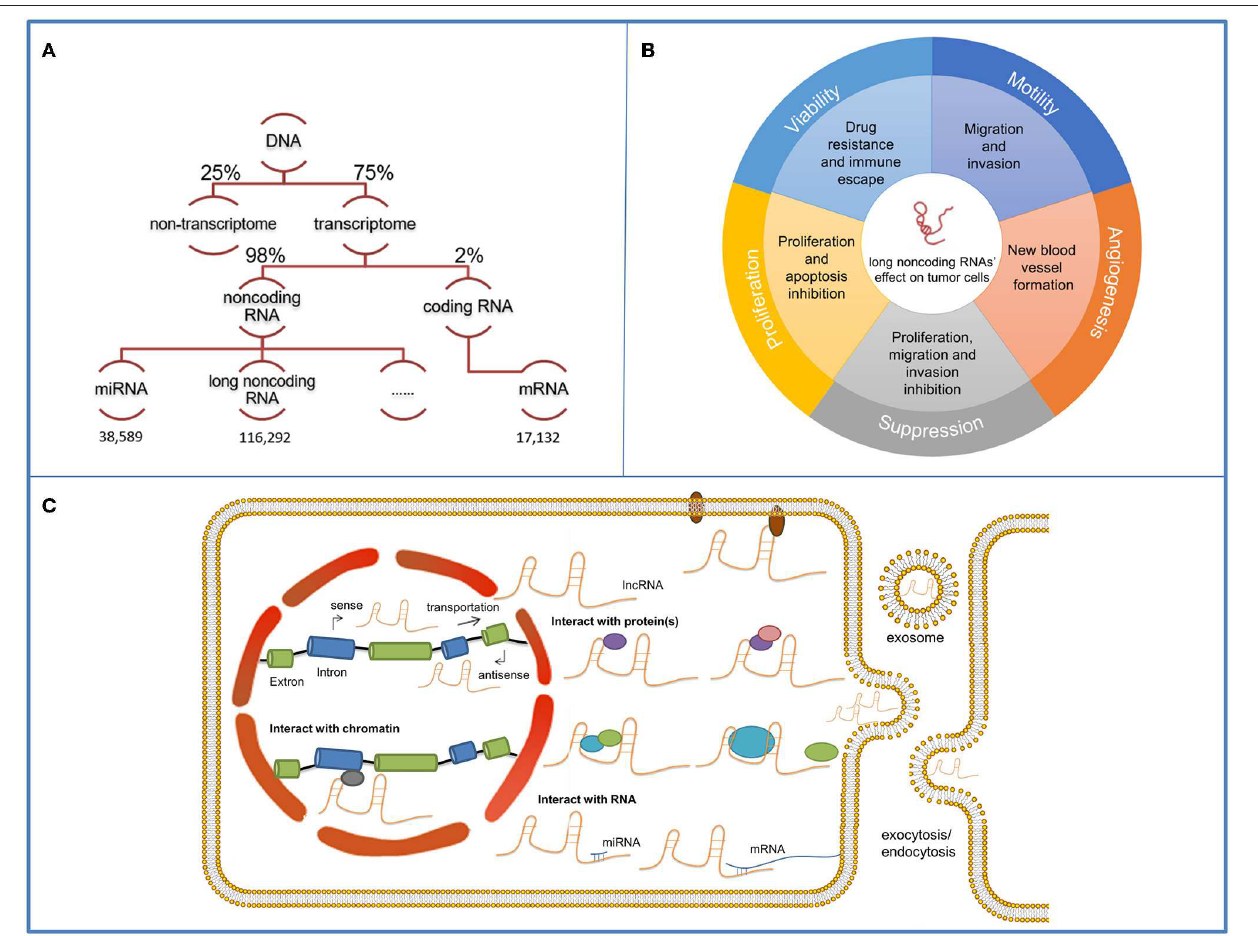
FIGURE 1 | Functions and mechanisms of long non-coding RNAs (lncRNAs). The schematic illustrates lncRNAs and their functions and mechanisms in tumor cells. (A) Among the 75% actively transcribed sequences in the human genome, 98% are non-coding sequences where long non-coding sequences occupy the majority. The quantity of miRNAs, lncRNAs and miRNAs mapped on the schematic are obtained from the respective databases. (B) LncRNAs’ functions on cancer development contain viability, motility, angiogenesis, proliferation promotion, and suppression. (C) LncRNAs have distinct working compartments. They can assemble with nucleus proteins and regulate transcription by interacting with the histone proteins or the promoter regions. They can also transmit to the cytoplasm and participate in signaling transmission by mediating the modification of components in cellular pathways. They can be contained in exosomes and delivered for intercellular communication. Mechanically, they can interact with protein/protein complex and form protein-RNA complex, serve as a scaffold and promote the assembling of proteins or complementary bind to RNAs to exert their